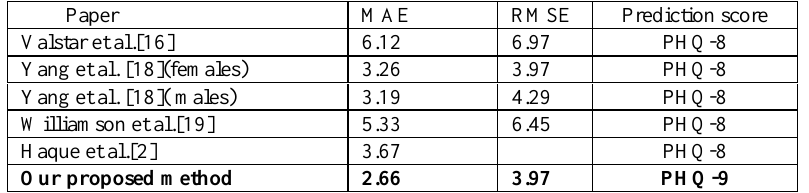
Table 2. Comparison with other